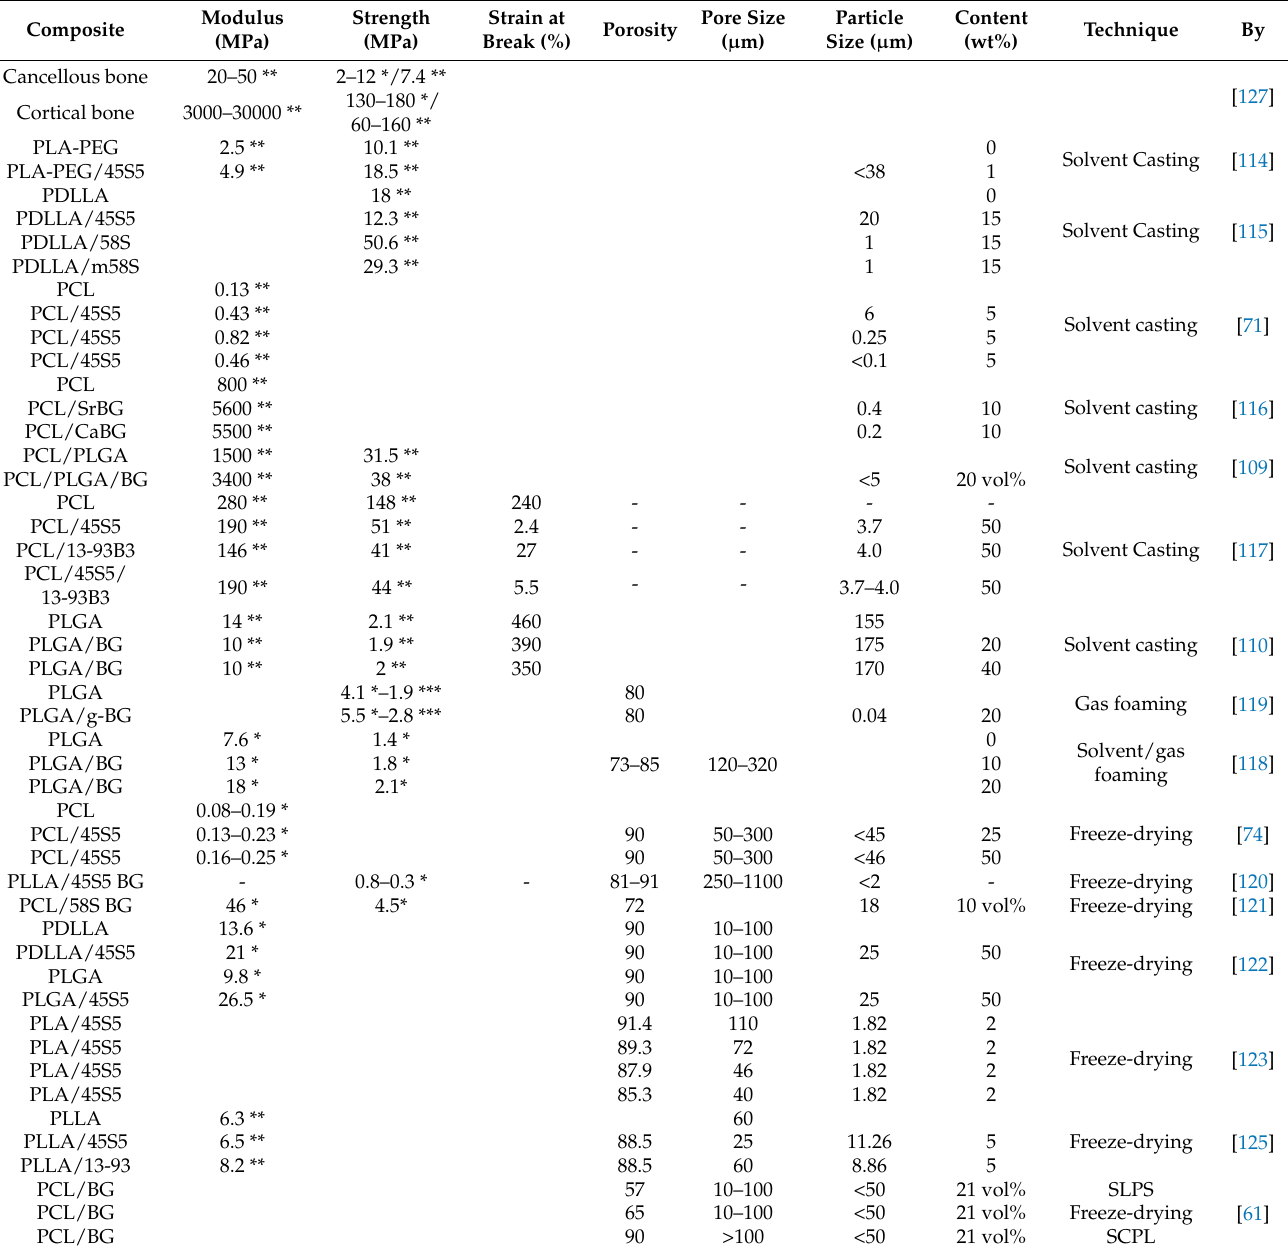
Table 1. Principal properties of solvent route molding investigations. With * the compression, ** tensile and *** flexural modulus/strength (not filled cells mean no